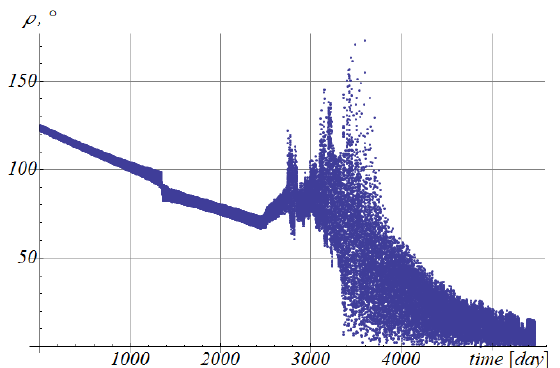
Figure 11. Evolution of angle ρ in scenario